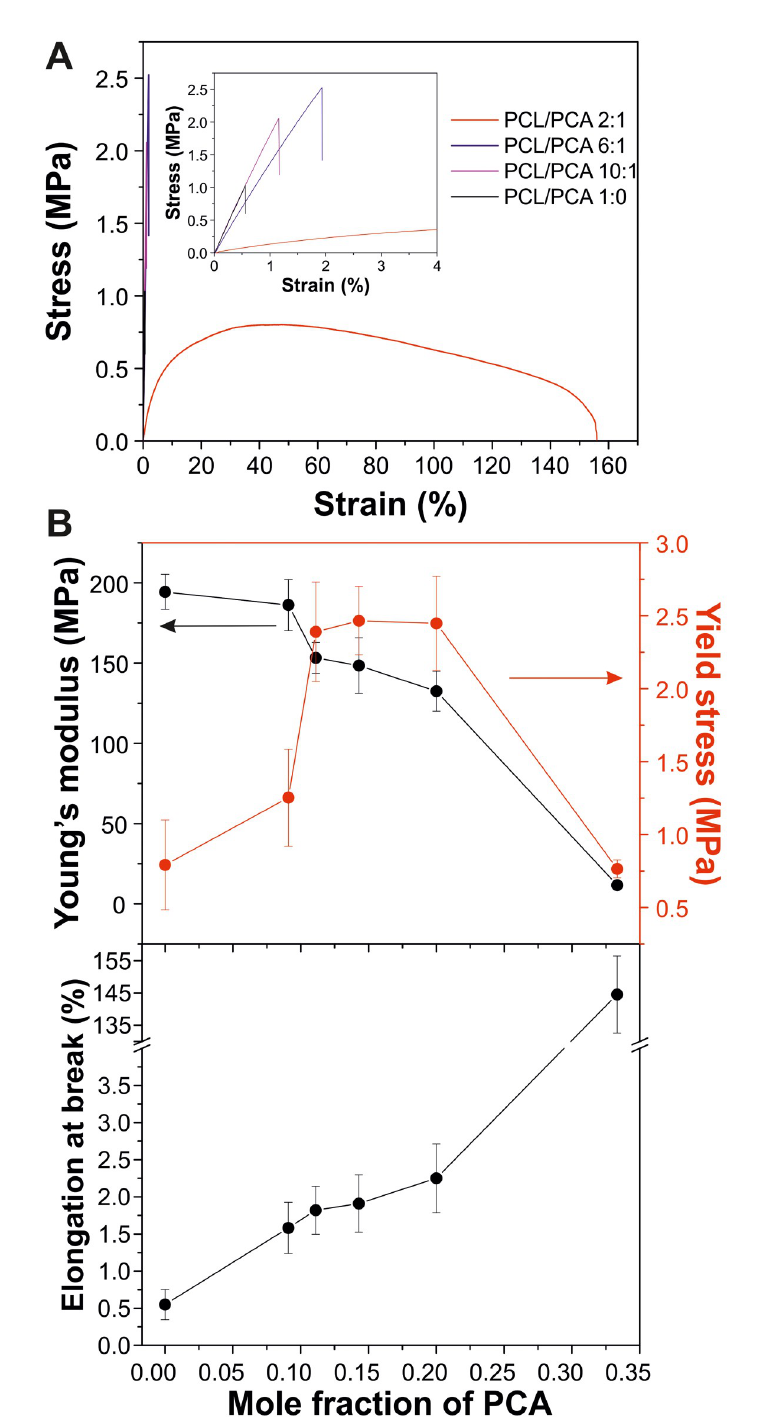
Fig 4. Mechanical characterization of the biopolymers. (A) Stress-strain curves of PCL/PCA 1:0, 10:1, 6:1, and 2:1 films. The inset shows a magnification at low strain values. (B) Variation of Young’s modulus, yield stress, and elongation at break as a function of the mole fraction of